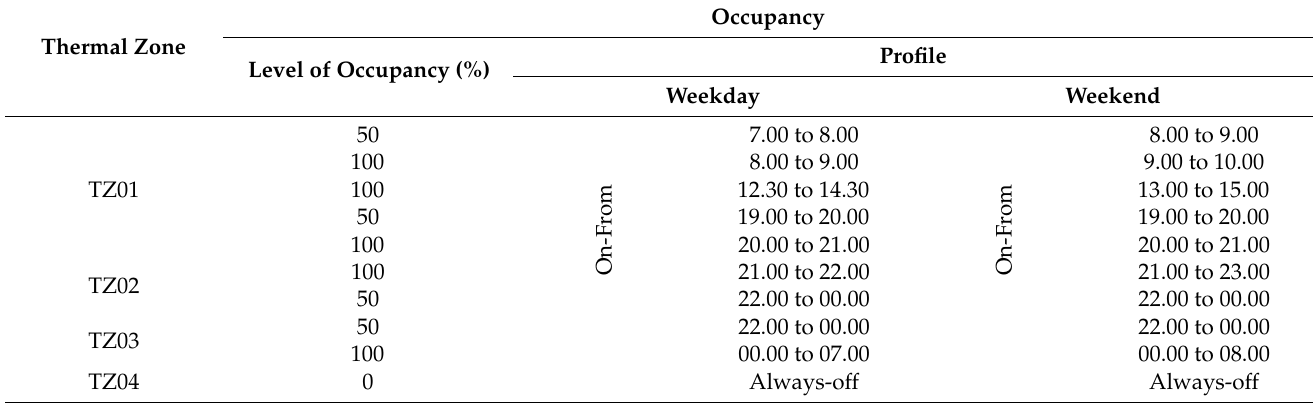
Table 3. Occupancy schedule defined detailed by thermal